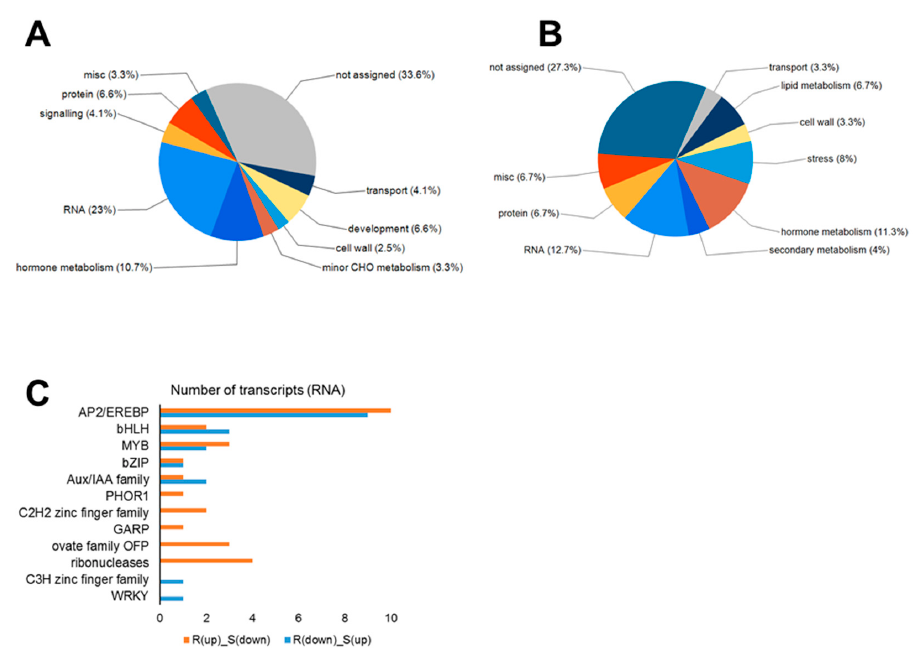
Figure 7. Distribution of the number of transcripts showing opposite regulation patterns in the resistant (R) rutabaga ‘Wilhelmsburger’ and the susceptible (S) ‘Laurentian’ at 7 days after inoculation with Plasmodiophora brassicae , using Mapman annotation. ( A ) Pie chart generated from transcripts upregulated in ‘Wilhlemsburger’ and downregulated in ‘Laurentian.’ (B ) Pie chart generated from transcripts downregulated in ‘Wilhelmsburger’ and upregulated in ‘Laurentian.’ ( C ) Number of transcripts related to RNA regulation.